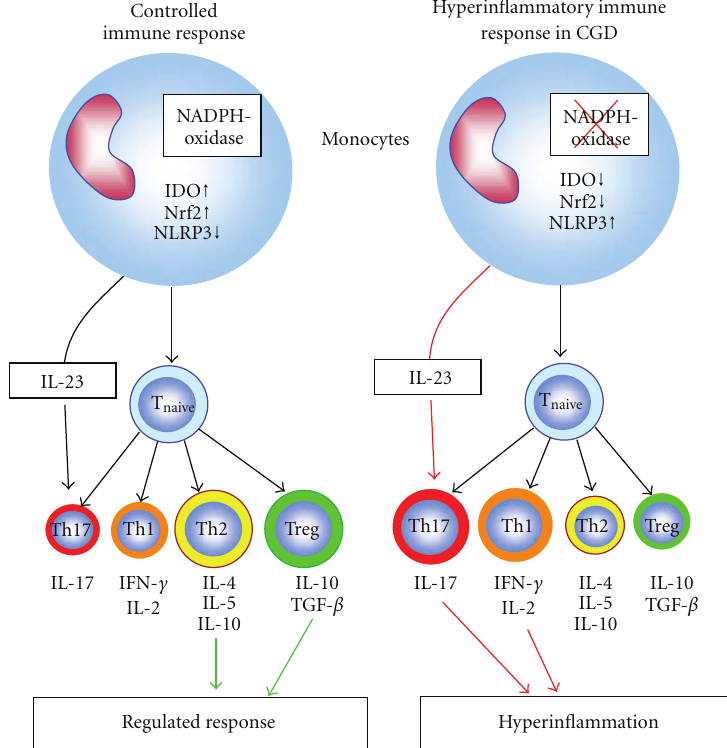
Figure 2: Other recently proposed mechanisms of hyperinflammation in CGD. Three independent mechanisms leading to hyperinflam- mation with increased numbers of Th17 cells have been recently proposed in CGD: Reduced IDO and Nrf2 activity and increased NLRP3